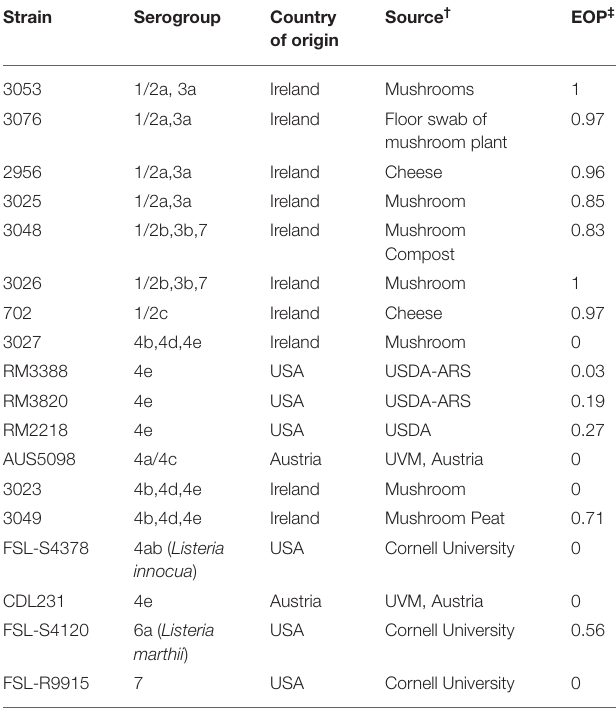
TABLE 1 | Origin and serogroup of L. monocytogenes strains used in this study.